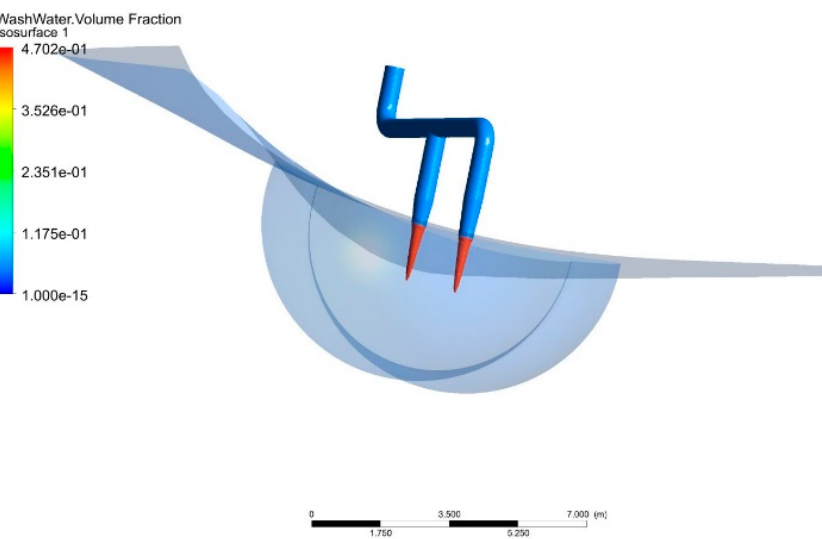
Figure 22. Scrubber Wash Water Volume Fraction of 0.45 isosurface development.